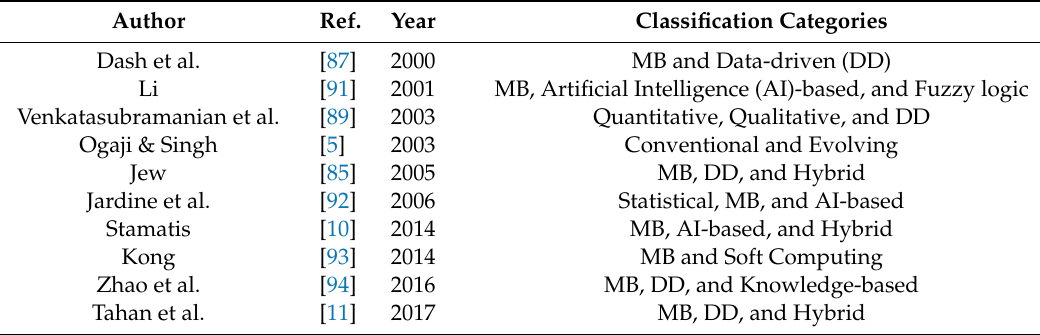
Table 3. Categorization of fault diagnostic methods presented in